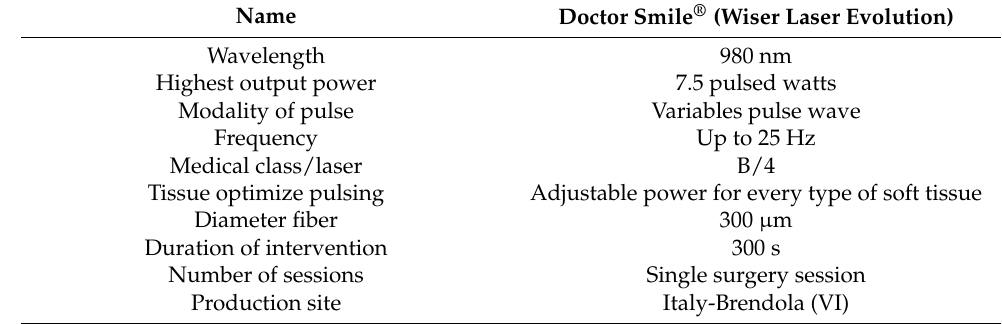
Table 3. Setting of the